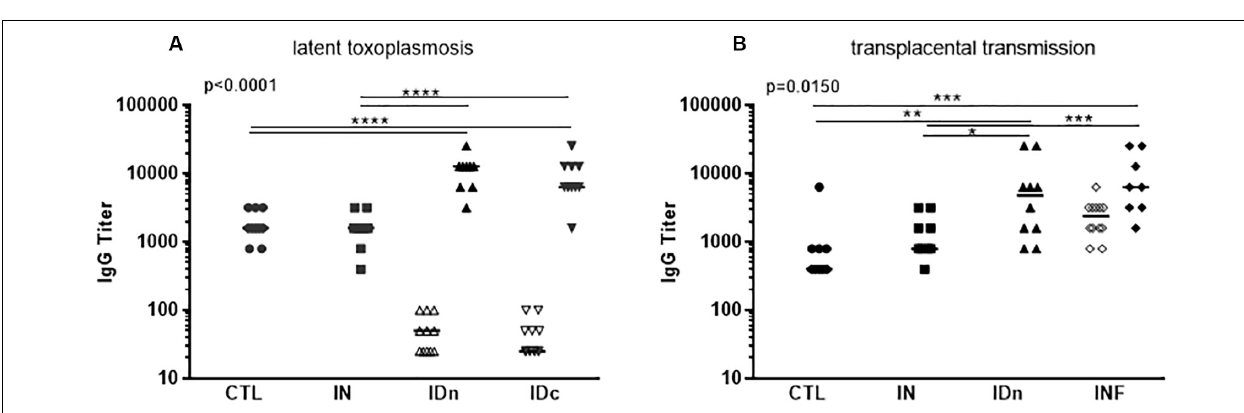
FIGURE 4 | Humoral immune response of sheep following vaccination with DGNP/TE and infection with T. gondii . (A) Sheep from the latent experiment CTL: inoculated with DGNP alone as control; IN: vaccinated by nasal route; IDn: vaccinated by intradermal route in the neck area; and IDc: vaccinated by intradermal route in the cheek area. (B) Sheep from the transplacental transmission experiment CTL: inoculated with DGNP alone as control; IN: vaccinated by nasal route; IDn: vaccinated by intradermal route in the neck area; INF: experimentally primary infected as protected control. Specific anti- T. gondii IgG titer were explored by endpoint ELISA at D80 after the first inoculation: (A, B) n = 12/group (open symbols) and after infection (closed symbols) at the end of experiments (A) n = 10/group (B) CTL n = 9; IN n = 9; IDn n = 10; and INF n = 8 infected pregnant sheep. Median and individual data points are shown. Since axis is logarithmic, negative values are not plotted and are < 25. Statistical analysis was performed thanks to two-way ANOVA (A) p < 0.0001 and (B) p = 0.0150 and Tukey’s multiple comparisons posttests * p < 0.05, ** p < 0.01, *** p < 0.001, and **** p <